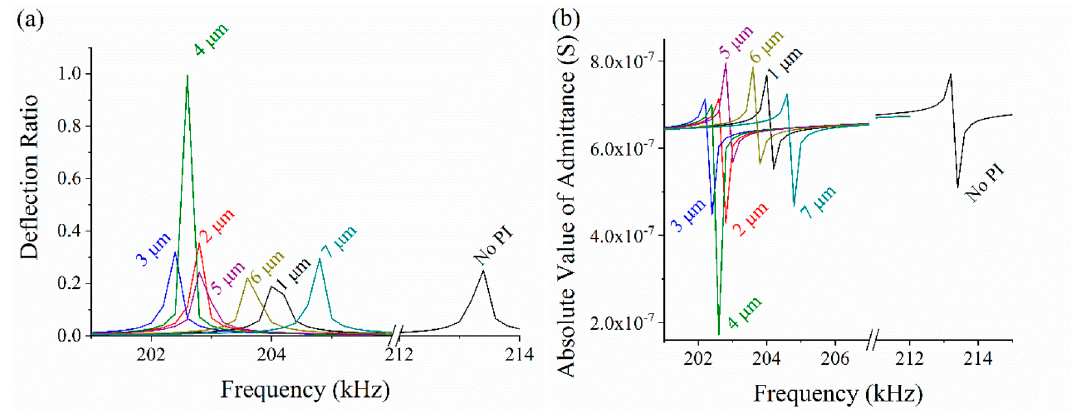
Figure 10. ( a ) Deflection displacement of the measuring point. ( b ) The chart of the